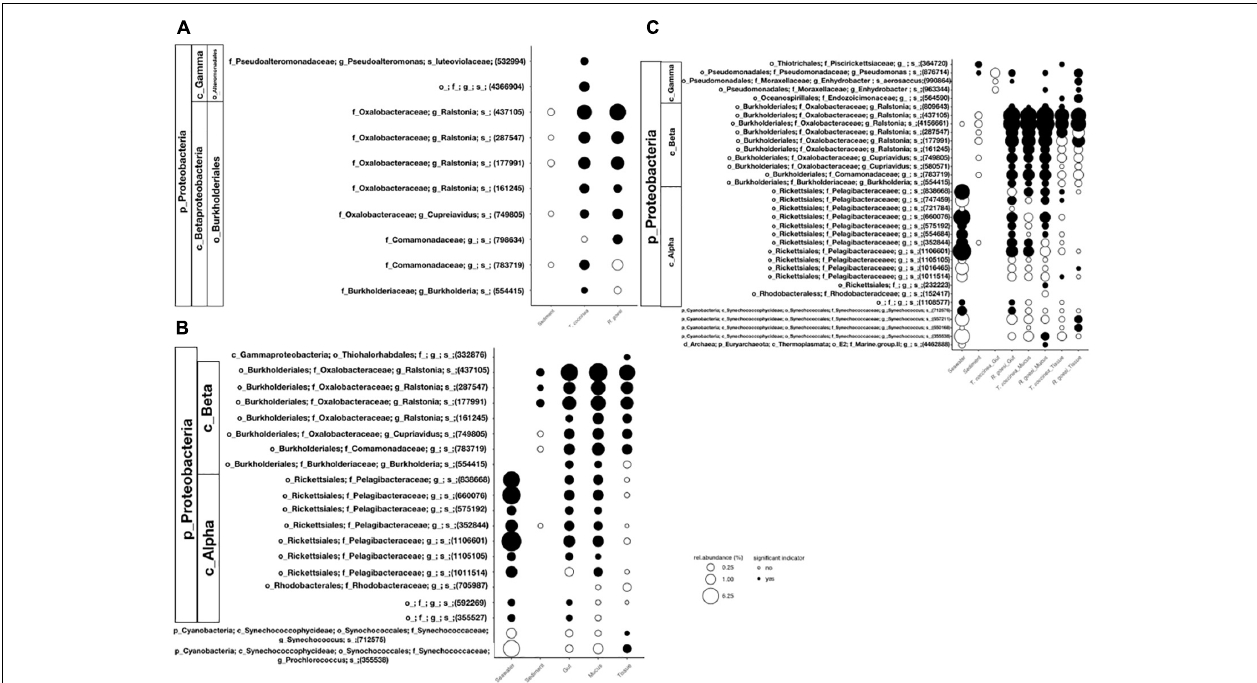
FIGURE 3 | Mean relative abundance of microbial indicator OTUs associated with (A) the cup corals R. goesi and T. coccinea , (B) the polyp compartment: surface mucus layer, tissue, and gastrovascular cavity (or “gut”), and (C) each species vs. polyp compartment combination. Seawater and sediment indicator OTUs are also shown when shared with any of the other sampling groups. Indicator taxa were identified with Indicator Value Analysis to be significantly associated with a certain sampling host or polyp compartment (indicated by black filled-in circles). Exclusive indicators for seawater, sediment or the gut of T. coccinea (in C ) are not show. Affiliation of each OTU shows its lowest identified taxonomic rank: (p) phylum, (c) class, (o) order, (f) family, (g) genus, and s (species), plus an OTU code (between